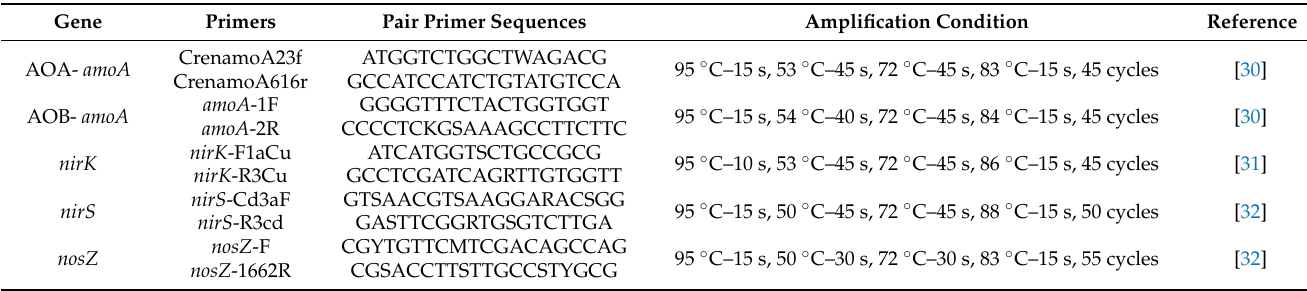
Table 1. Primers of nitrification functional genes (AOA amoA and AOB amoA ) and denitrification functional genes ( nirK , nirS , and nosZ ) and their thermal cycling conditions for qPCR reaction.